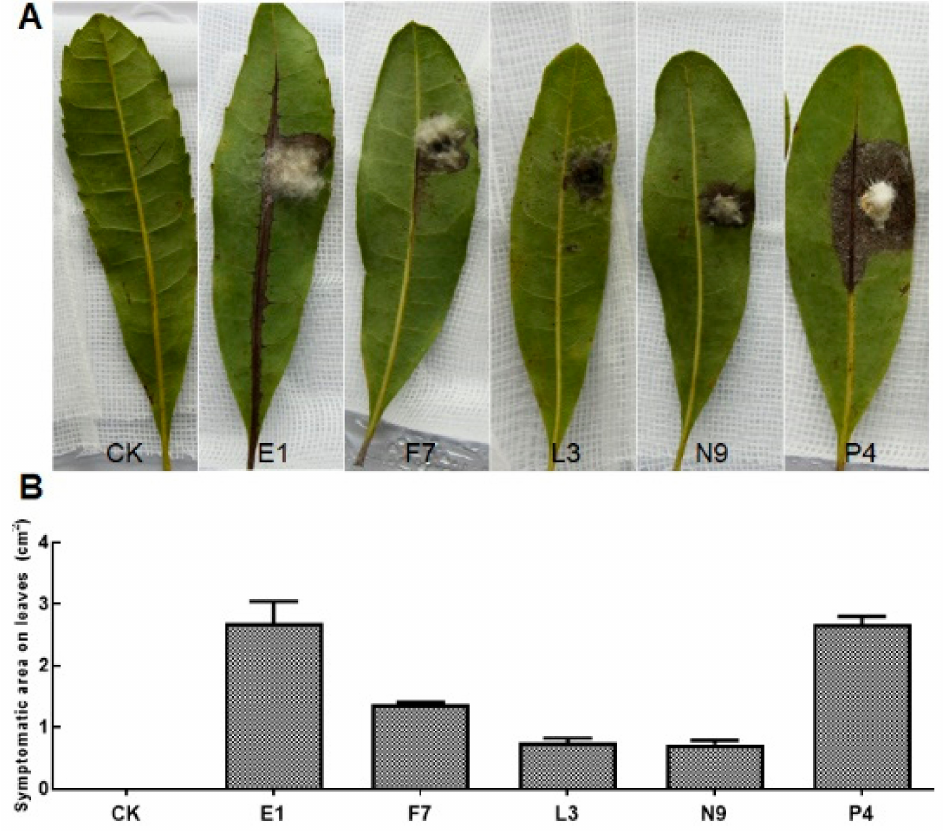
Figure 2. Pathogenicity tests of fungal isolates on detached bayberry leaves. ( A ) Symptoms on detached leaves causing by the inoculated fungal isolates; ( B ) the sizes (cm 2 ) of the symptomatic area measured by Image J. Isolates were inoculated on healthy leaves collected from healthy plants (cv. Dongkui) after surface-sterilization. Treated leaves were then placed on wet sterilized filter paper in petri dishes (13 × 13 cm), and kept in a growth chamber with controlled conditions of 28 ± 2 ◦ C; 75% ± 15% relative humidity and 12 h white light (12,250 cd) illumination for a week. Blank PDA plugs without mycelia were used as controls (CK, control check). Leaves were visually examined after 9 days and sizes of symptomatic areas on the leaves were recorded and measured using Image J. The experiment was repeated in triplicates three times. Fungal isolates causing no disease symptoms were not